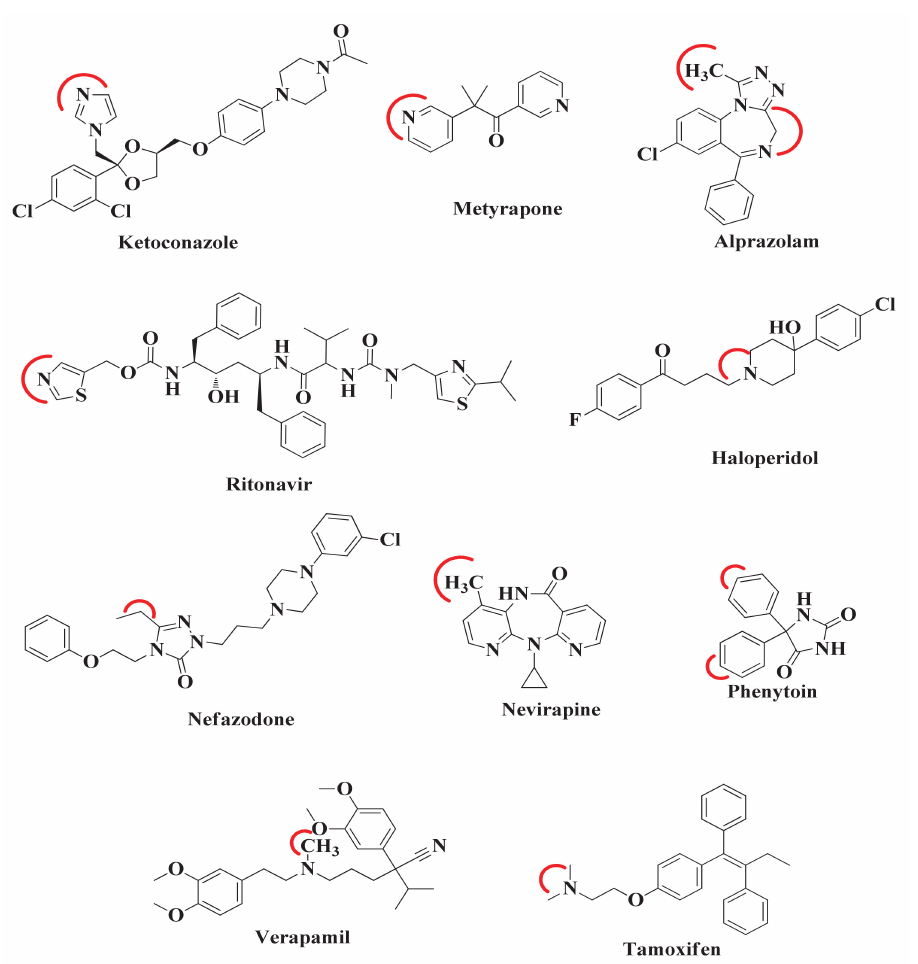
Figure 3. Chemical Structures of compounds. Red color indicates experimentally reported major